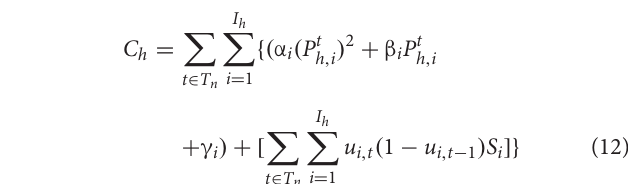
The demarcation is related to P d , and the situation boundary is determined according to the statistical law that µ = 1 accounted for 20% in each rough